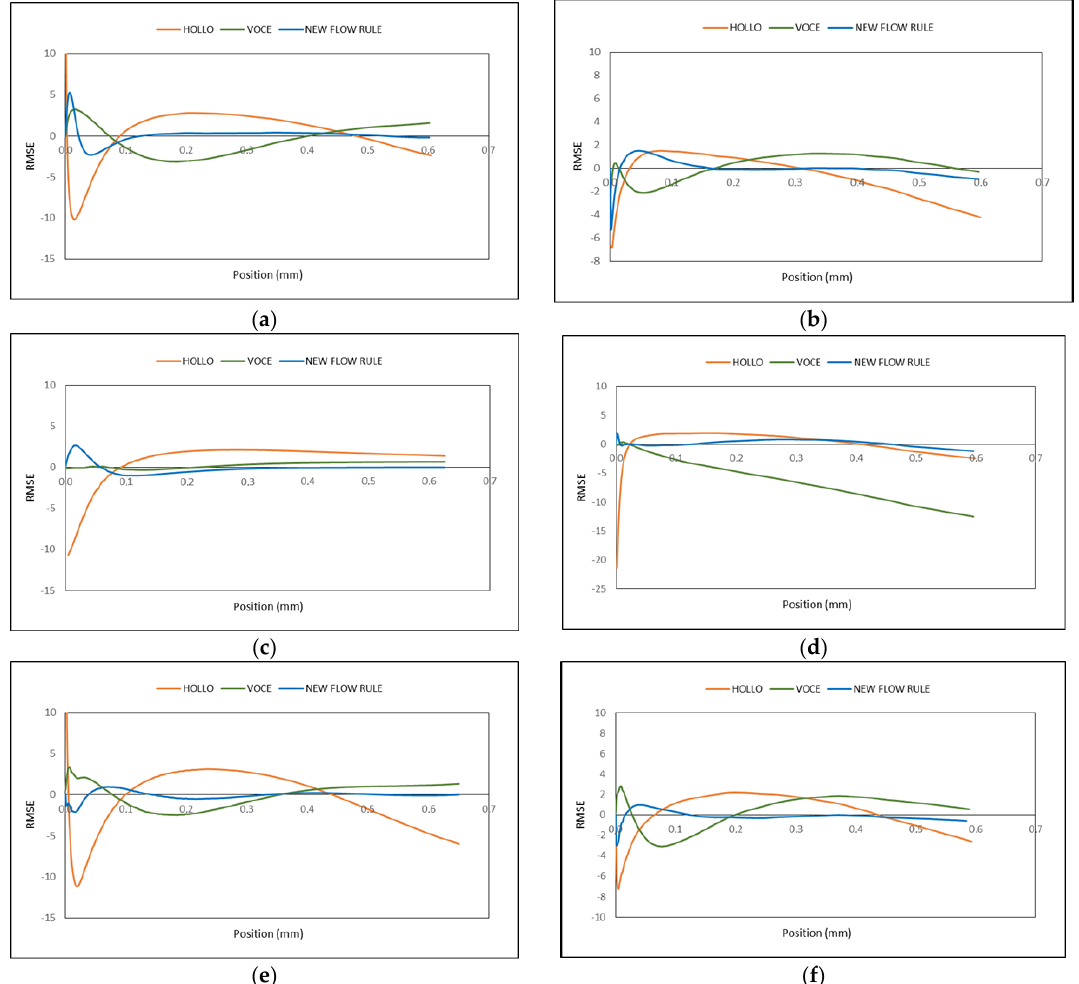
Figure 12. RMSE graphs of each flow rule in relation to the experimental curve for AA5083: ( a ) AA5083 at N0 and 25 °C; ( b ) AA5083 at N0 and 250 °C; ( c ) AA5083 at N2 and 25 °C; ( d ) AA5083 at N2 and 250 °C; ( e ) AA5083 at N2 + flash and 25 °C; ( f ) AA5083 at N2 + flash and 250 °C.